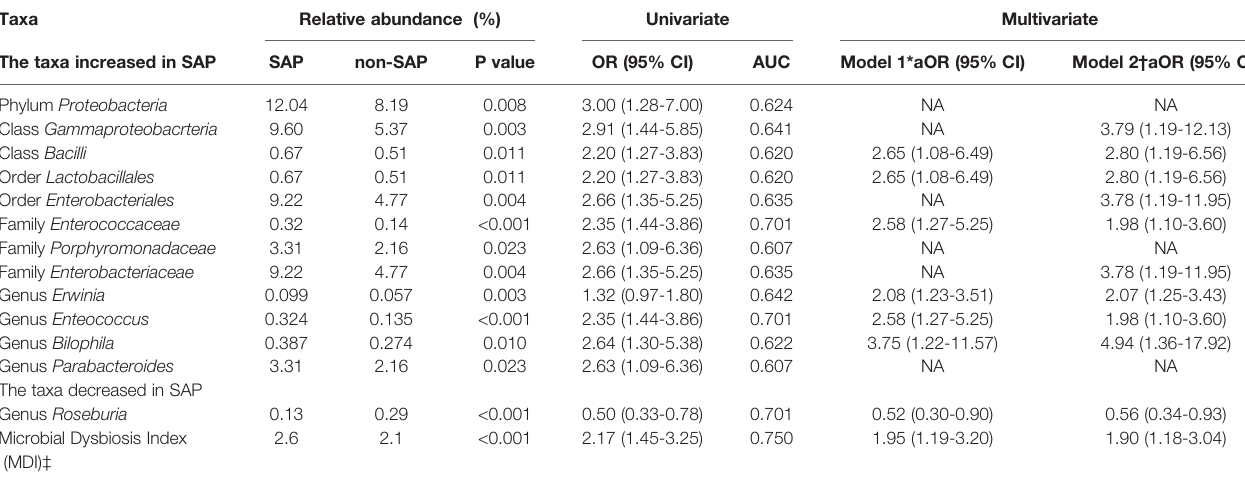
TABLE 2 | Relative abundance of selected microbial taxa in patients with and without SAP in the training cohort. Taxa Relative abundance (%) The taxa increased in